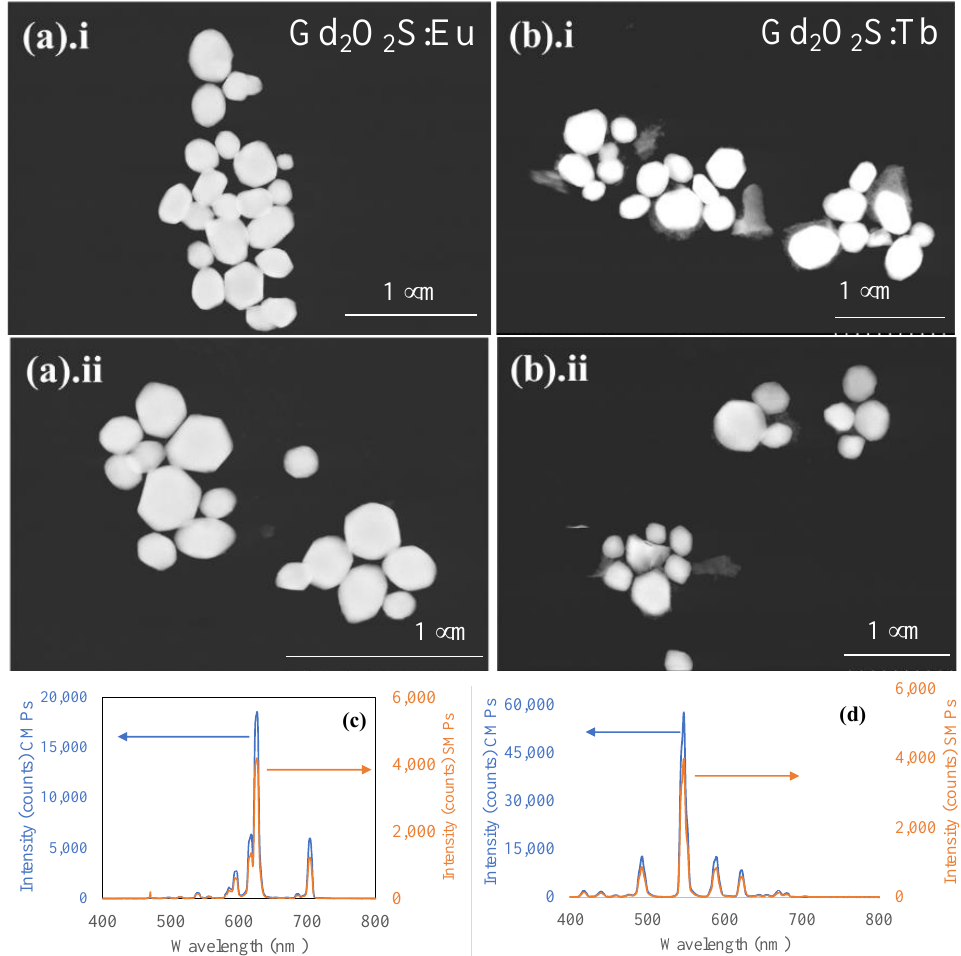
Figure 4. Particle separation via spontaneous sedimentation using DI water as a dispersion medium. STEM images of nano- and submicron-sized particles of ( a ). ( i,ii ) Gd 2 O 2 S:Eu and ( b ). ( i,ii ) Gd 2 O 2 S:Tb separated from 2.5 m commercial microparticles (CMPs) via sedimentation under normal gravity. Corresponding luminescence spectra of the separated nano- and submicron particles (SMPs) ( c ) Gd 2 O 2 S:Eu and ( d ) Gd 2 O 2 S:Tb particles compared to those of the pristine commercial 2.5 m micro-particles.